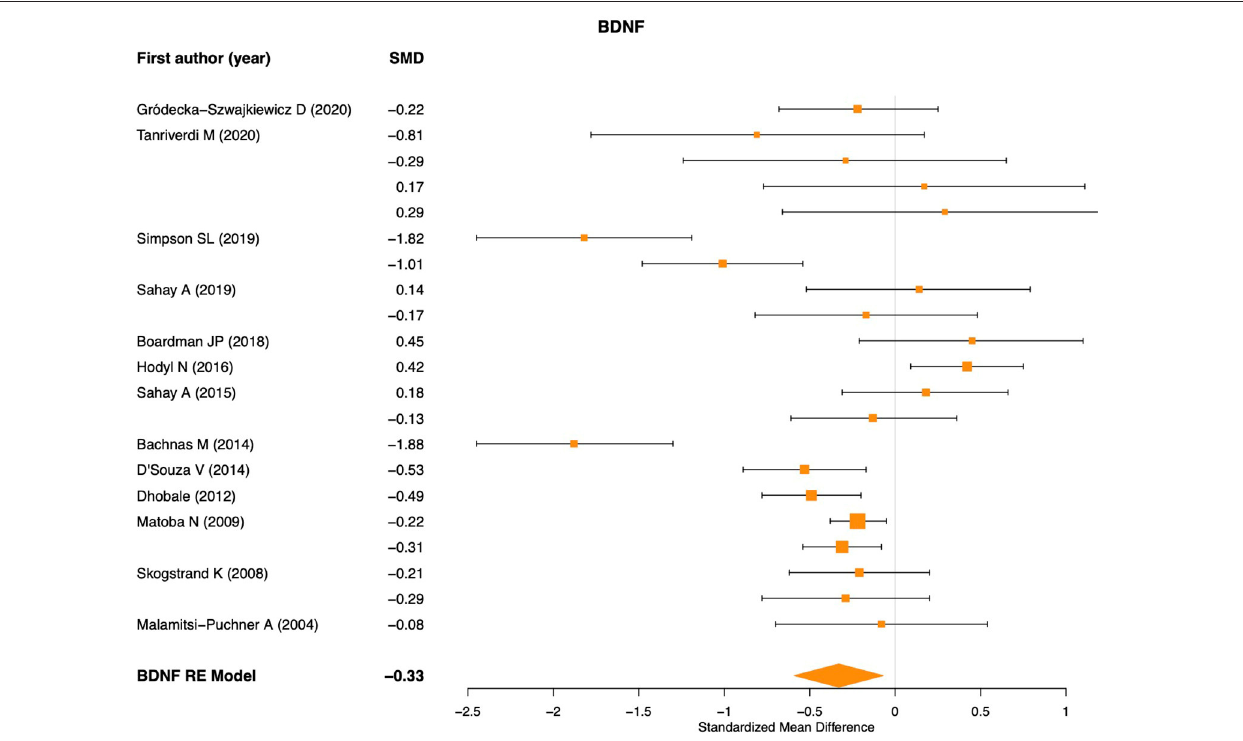
FIGURE 1 | BDNF meta-analysis. RE, random effects